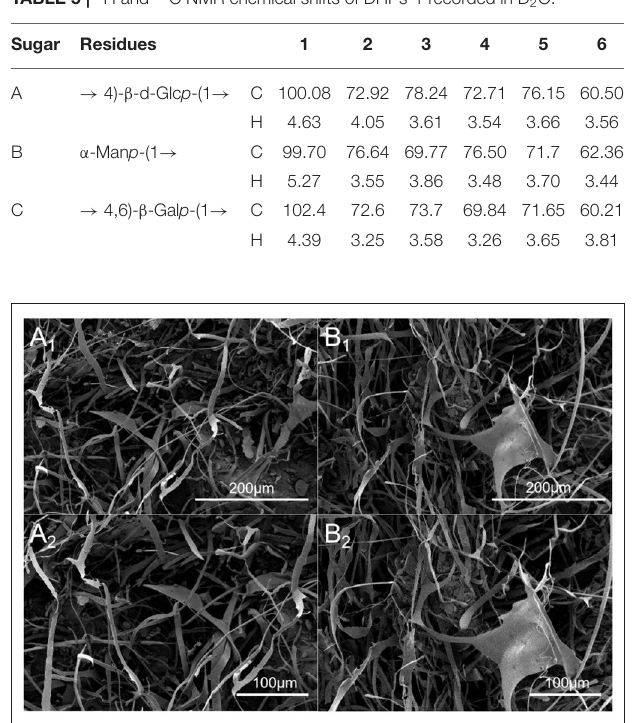
FIGURE 3 | SEM images of DHPs-1 ( A 1 , A 2 : different magnification of the same region; B1, B2 : different magnification of the same region; A 1 , B 1 , 800 × ; A 2 B 2 , 1,000 × ).